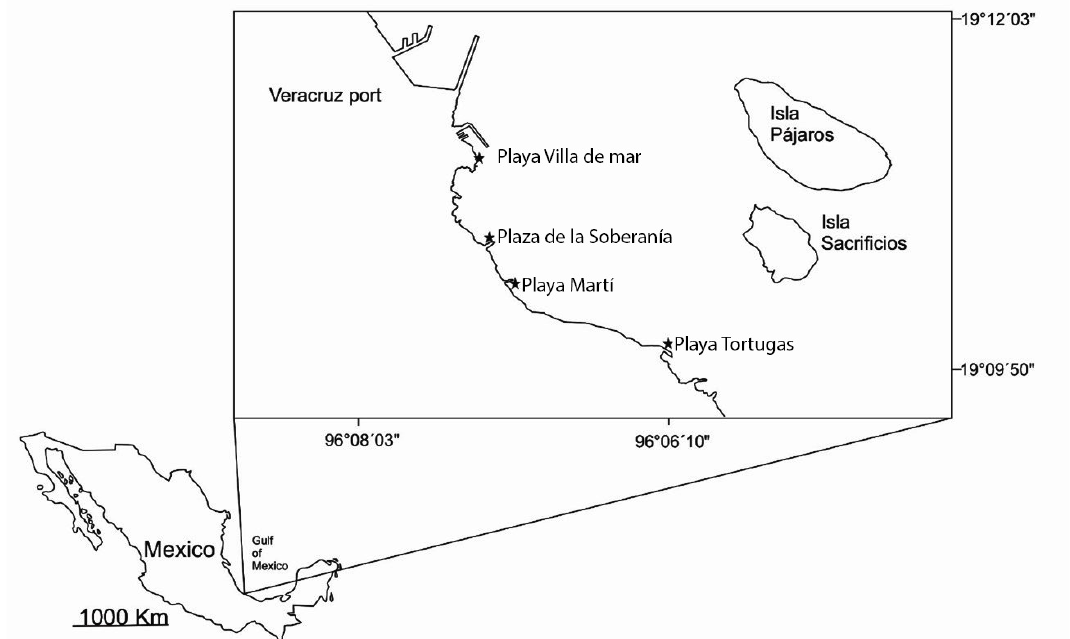
Figure 1. Location of the study area. Parque Nacional Sistema Arrecifal Veracruzano (PNSAV), SW Gulf of